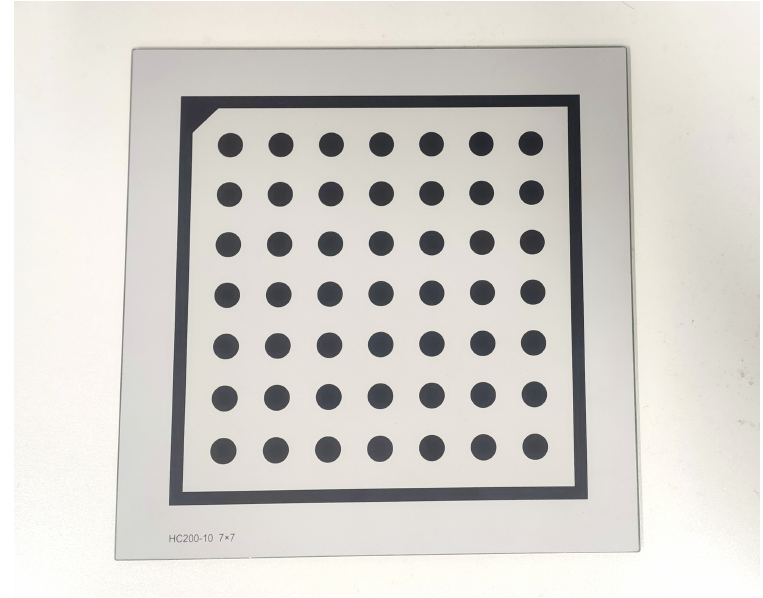
Figure 9. Calibration